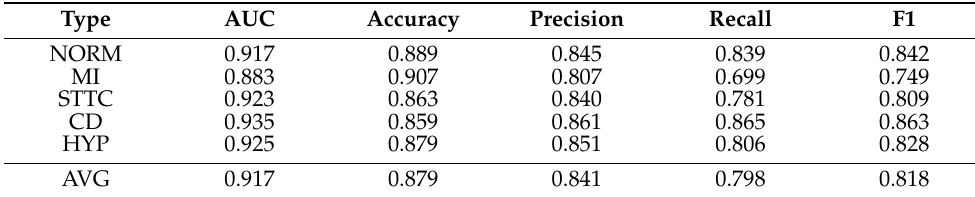
Table 7. Classification performance with the random auxiliary task on the PTB-XL dataset.